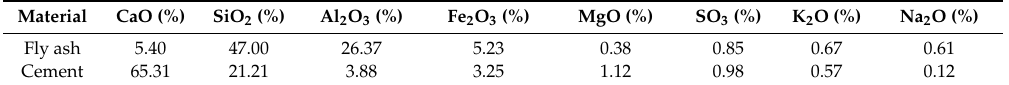
Table 1. Chemical compositions of fly ash and cement.